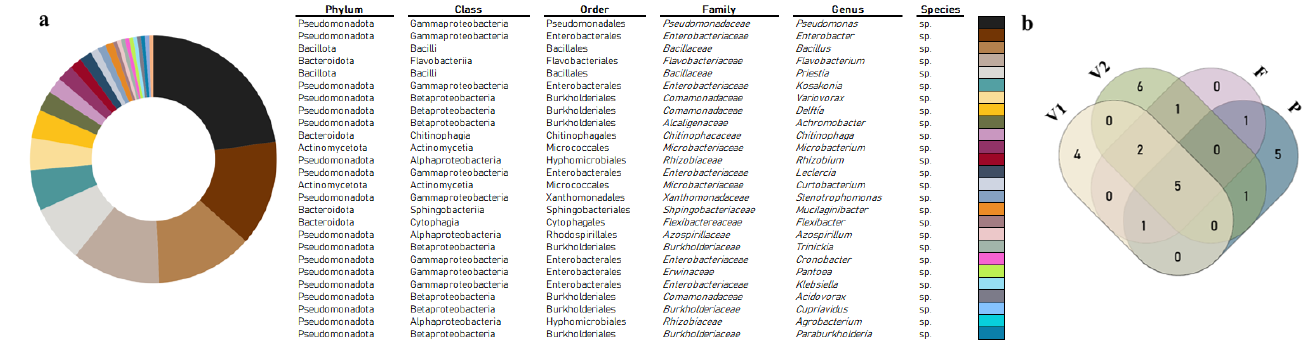
Figure 1. Global distribution of bacterial genera. ( A ) Circle chart showing global bacterial distribution by genera found in Phaseolus vulgaris L. during plant development. ( B ) Venn diagram of bacteria genera distribution in the four stages of plant development: beginning of vegetative stage — V1, end of vegetative stage — V2, flowering stage — F, and pod stage — P.